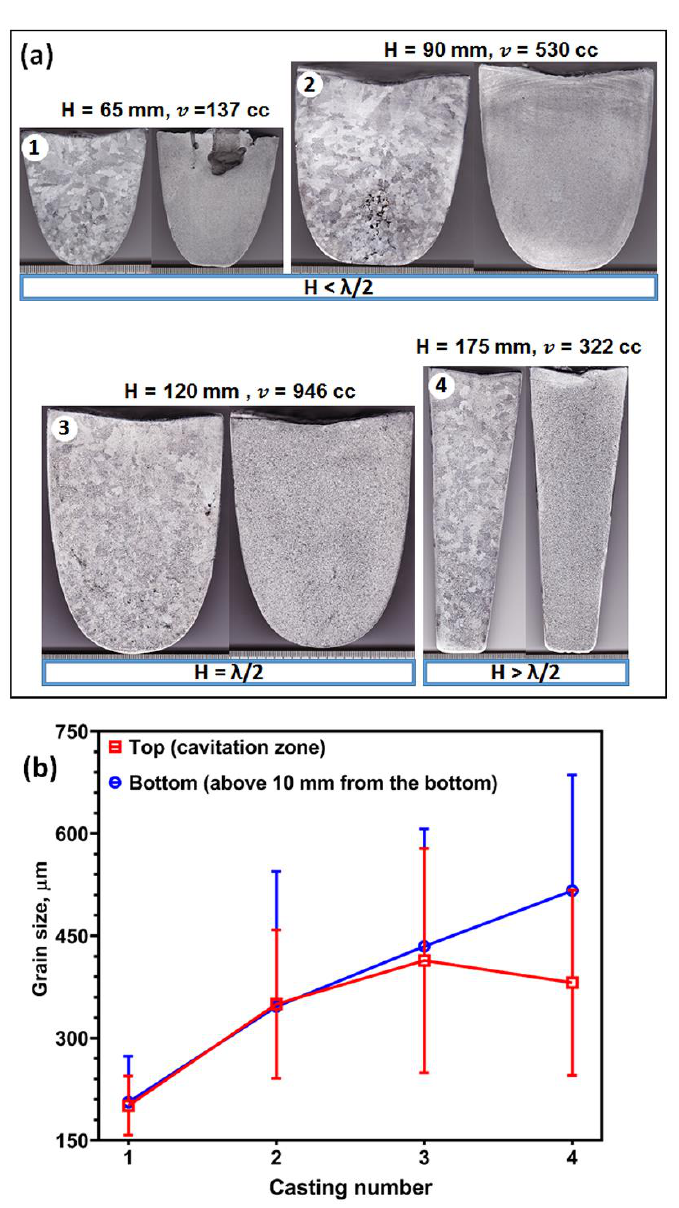
Figure 12. ( a ) Effect of casting volume (𝑣) and height (H) on the macrostructure after UST of an Al-2Cu alloy and ( b ) the grain size measured from the top and bottom of the casting. (λ/2 = 125 mm refers to the half wavelength distance of the sonotorde)